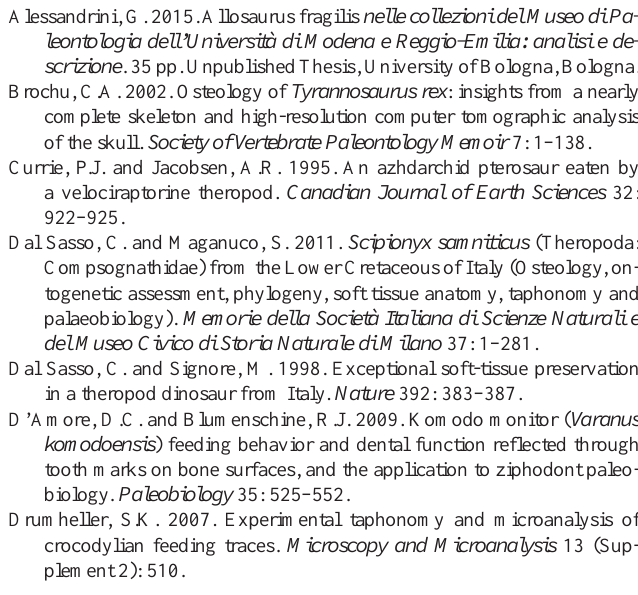
Figure 2. We thank Editor Stephen Brusatte (University of Edinburgh, UK), Susannah Maidment (University of Brighton, UK) and an anony- mous reviewer for providing useful advice to this